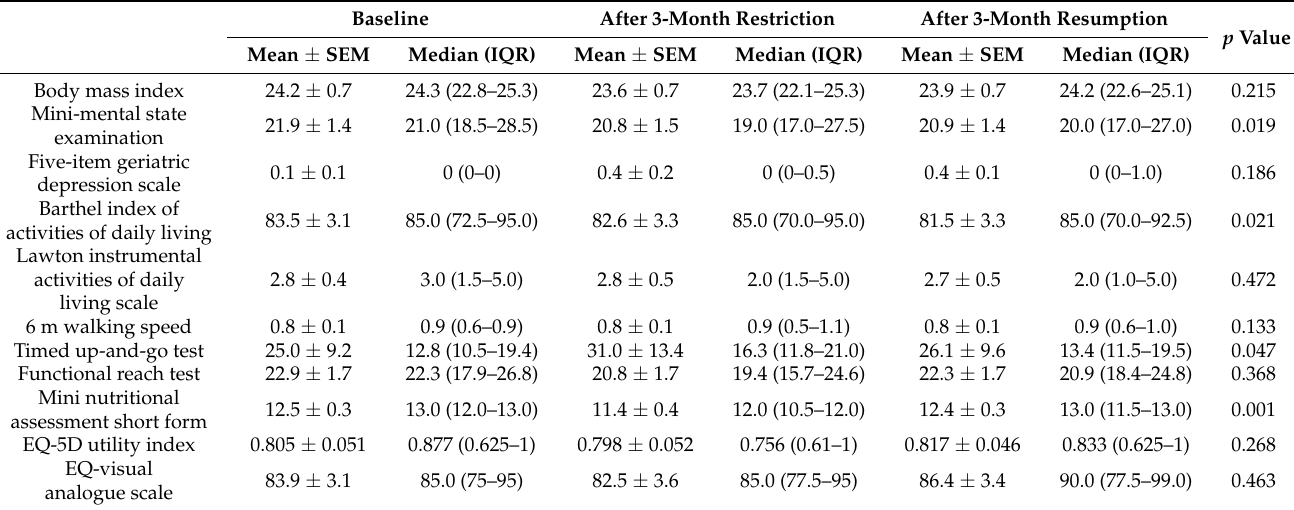
Table 2. Change of physical and cognitive functions, and nutritional status at baseline and after restriction and resumption of daycare services.